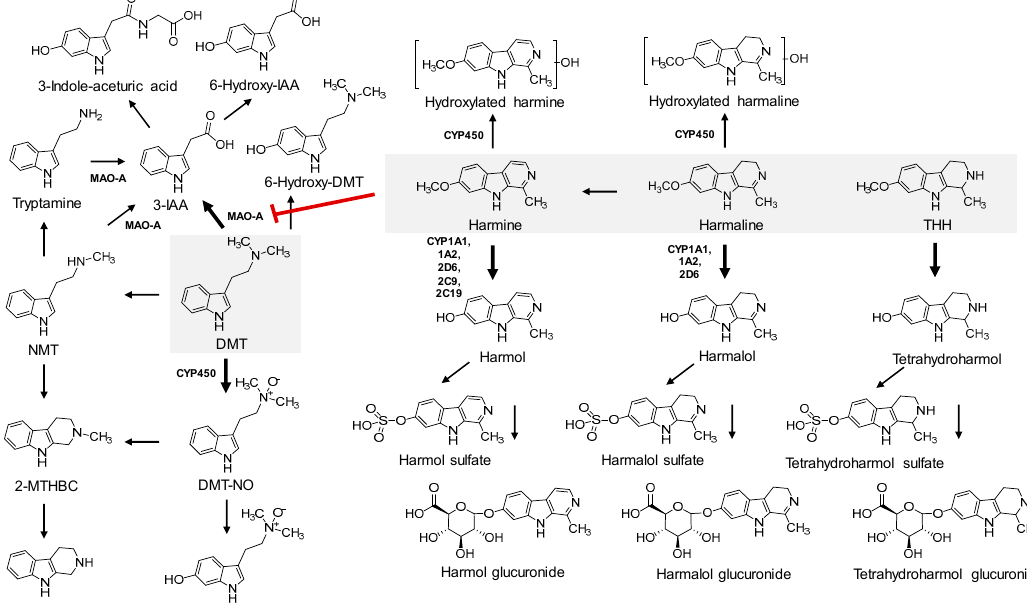
Figure 3. Metabolic pathways of N , N -dimethyltryptamine (DMT) and of β -carboline alkaloids harmine, harmaline, and tetrahydroharmine. The influence of β -carbolines on the metabolism of DMT is also represented in red. 2-MTHBC: 2-Methyl-1,2,3,4-tetrahydro- β -carboline; 3-IAA: 3-Indole-acetic acid; DMT-NO: DMT- N -oxide; NMT: N -Methyltryptamine; THBC: 1,2,3,4-Tetrahydro- β -carboline.